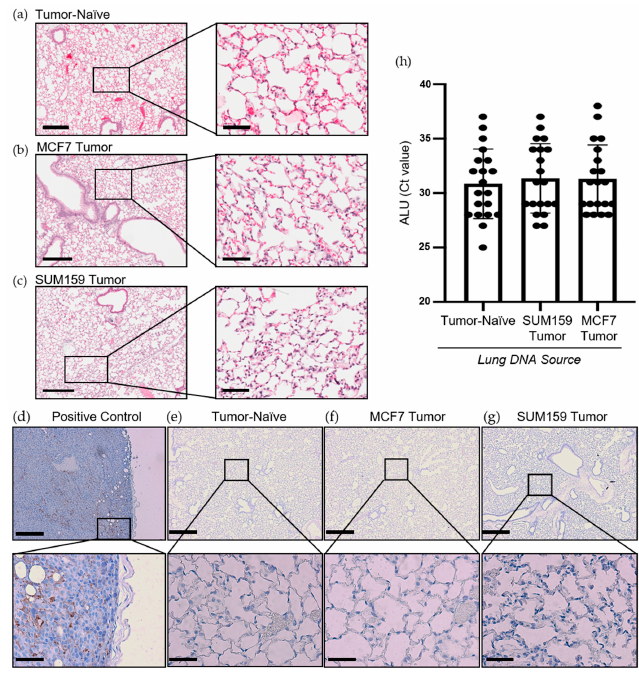
Figure 2. Mice bearing either SUM159 or MCF7 primary breast tumors had no evidence of lung metastasis at the time of the endpoint/analysis . Triple-negative SUM159 or luminal A MCF7 human breast cancer cells were injected into the mammary fat pad of female nude mice, and primary breast tumors were allowed to develop up to a mean tumor size of 1500 mm 3 . Animals were euthanized at the endpoint, and lungs were harvested and either formalin-fixed or snap-frozen. ( a – g ) Formalin-fixed, paraffin-embedded tissues were sectioned (4 µm) and stained with ( a – c ) hematoxylin and eosin (H&E) or ( e – g ) subjected to immunohistochemistry with a human-specific mitochondrial cytochrome C oxidase antibody prior to analysis by a trained veterinary pathologist (P.K.). Four random sections/organ/mouse and 10 high-powered fields of view (FOVs)/section were analyzed at 400 × magnification for the presence of metastatic tumor cells (n = 9 mice/group). Representative lung sections are shown from ( a , e ) tumor-naïve control mice; ( b , f ) MCF7 tumor-bearing mice and ( c , g ) SUM159 tumor-bearing mice. ( d ) Positive control; MCF7 primary human breast tumor tissue. Scale bars: low magnification images = 300 μ m (left panels ( a – c ) and top panels ( d – g ) and high magnification images = 70 μ m (right panels ( a – c ) and bottom panels ( d – g ). ( h ) DNA was isolated from snap-frozen lung tissue from tumor-naïve control mice, MCF7 tumor-bearing mice and SUM159 tumor-bearing mice ( n = 15/group) and subjected to qPCR analysis using primers specific to the human ALU sequence. tumor-naïve mice ( p ≤ 0.05) (Figure 4a–e). The expression of lysyl oxidase (LOX) and CCL2 was also examined. Expression of LOX has been shown to be increased in the premetastatic organ microenvironment, inducing collagen crosslinking and promoting the recruitment of BMDCs for ECM remodeling [20]. Coupled with collagen crosslinking, CCL2 acts as a strong attractant for BMDCs cells. We observed a significant increase in LOX and CCL2 expression in the lungs of mice bearing triple-negative SUM159 breast tumors relative to lungs from mice bearing luminal A MCF7 tumors or tumor-naïve mice (Figure 4f,g). Taken together, these results indicate that the presence of a triple-negative SUM159 primary tumor induces the development of premetastatic niche characteristics in the lung by enhancing the expression of ECM proteins and effector molecules that aid in the recruitment of BMDCs.